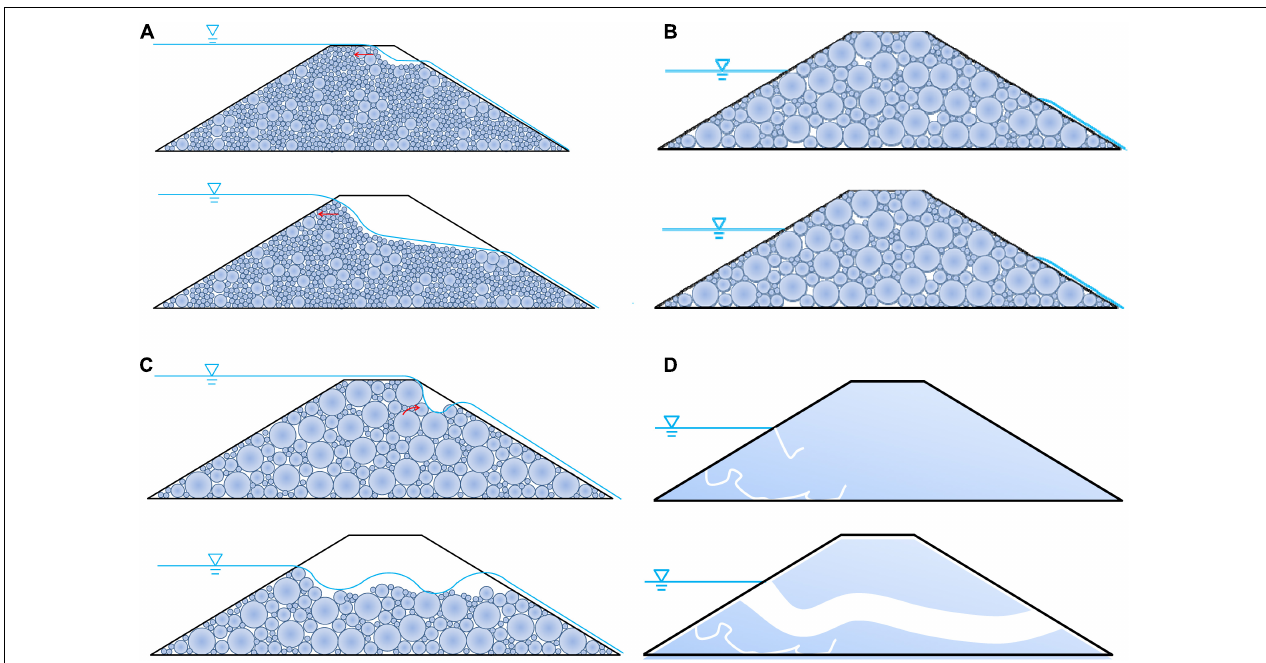
FIGURE 12 | Failure patterns of a landslide dam for different materials: (A) sliding failure for a fine-grained landslide dam (Wang et al., 2018; Jiang et al., 2019; Zhu et al., 2019); (B) no failure for a coarse-grained landslide dam; (C) erosion failure for a well-graded landslide dam (Xiong et al., 2018); (D) piping failure for a gap-graded landslide dam (Quenta et al., 2007; Xiong et al., 2018).